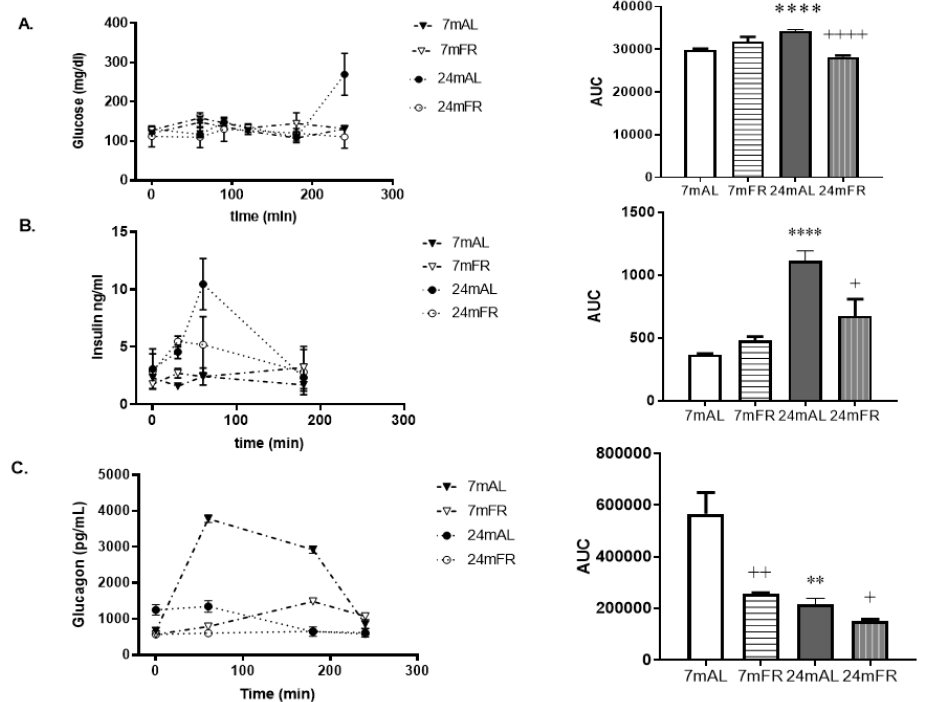
Figure 1. Evolution of serum glucose ( A ), insulin ( B ), and glucagon ( C ) levels in 7- and 24-month-old rats fed ad libitum (AL) or food-restricted (FR) after an oral lipid loading test (OLLT). Blood aliquots from the tail vein were taken at 0, 30, 60, 90, 120, 180, and 240 min after the OLLT. Serum samples obtained by blood centrifugation at each time were pooled and used for the measurement of hormones and metabolites, made in duplicates. Results are the mean ± SEM of 8–10 rats per group. Overall changes in glucose, insulin and glucagon levels during the oral lipid loading test were calculated as the area under the curve (AUC) above the basal level. Unpaired Student’s t -test, ** p ≤ 0.0025, **** p ≤ 0.0001 compared to 7-month-old rats under the same feeding protocol; + p ≤ 0.01, ++ p ≤ 0.0025, ++++ p ≤ 0.0001 compared to the age -matched ad-libitum-fed rats.